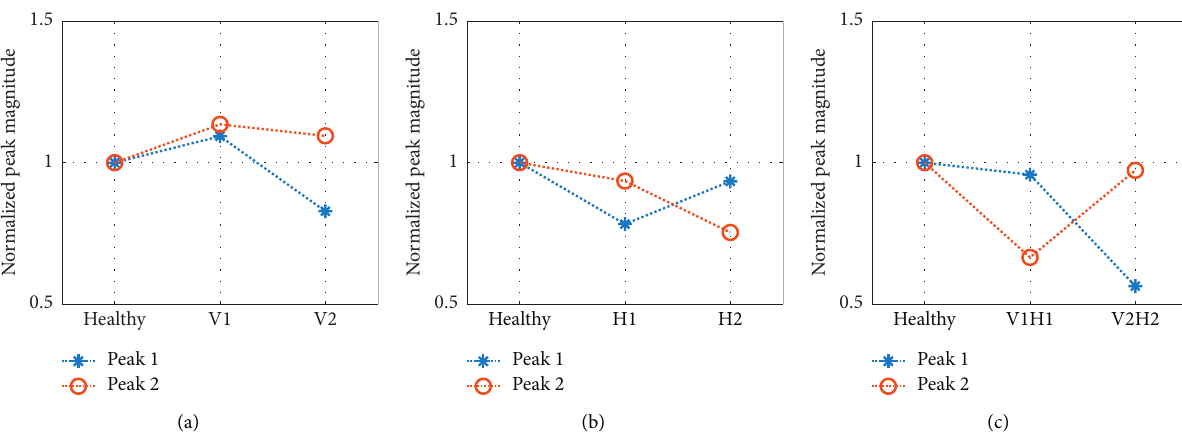
Figure 27: Shifts in peak magnitudes due to interface detaching defects. (a) Cases: V1, V2. (b) Cases: H1, H2. (c) Cases: V1H1, V2H2.